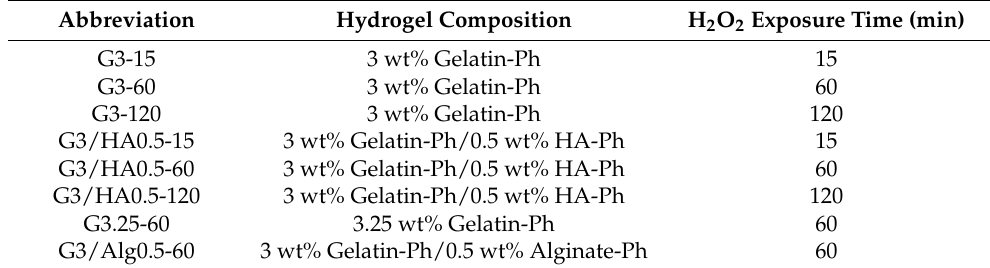
Table 1. The abbreviation of hydrogels and the H 2 O 2 exposure time applied to fabricate the hydrogels from the solutions containing 1 U/mL